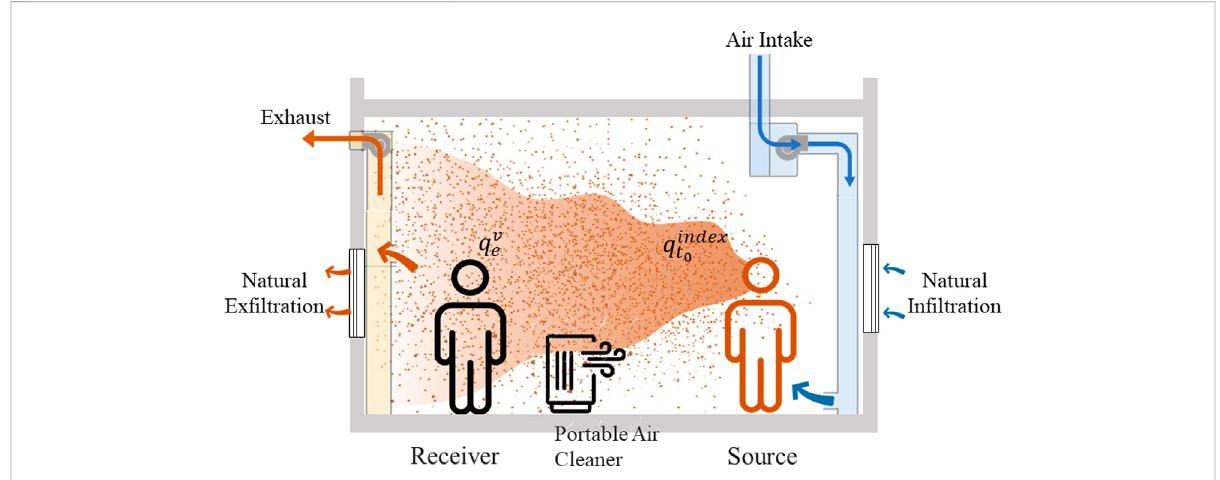
A conceptual diagram of airborne disease transmission of COVID-19 in an indoor room.